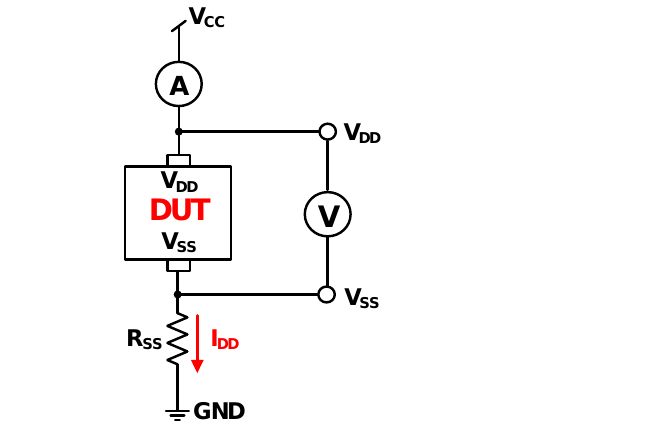
Figure 12. Setup of the proposed CA for measurement.